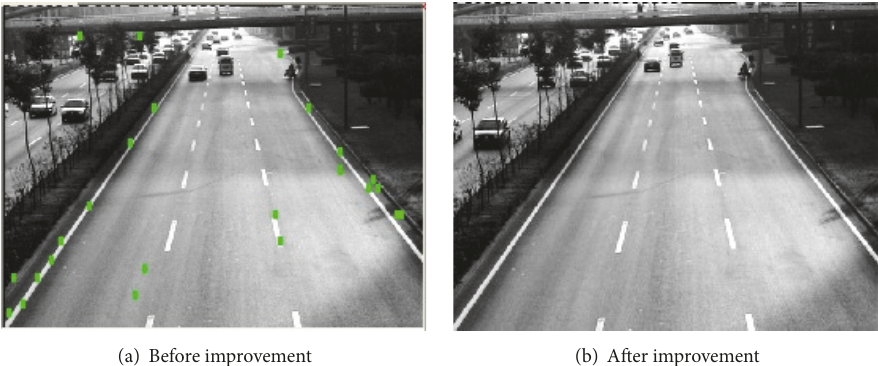
Figure 21: Comparison of the effects before and after the improvement of the algorithm for Xi’an South Second Ring Road.